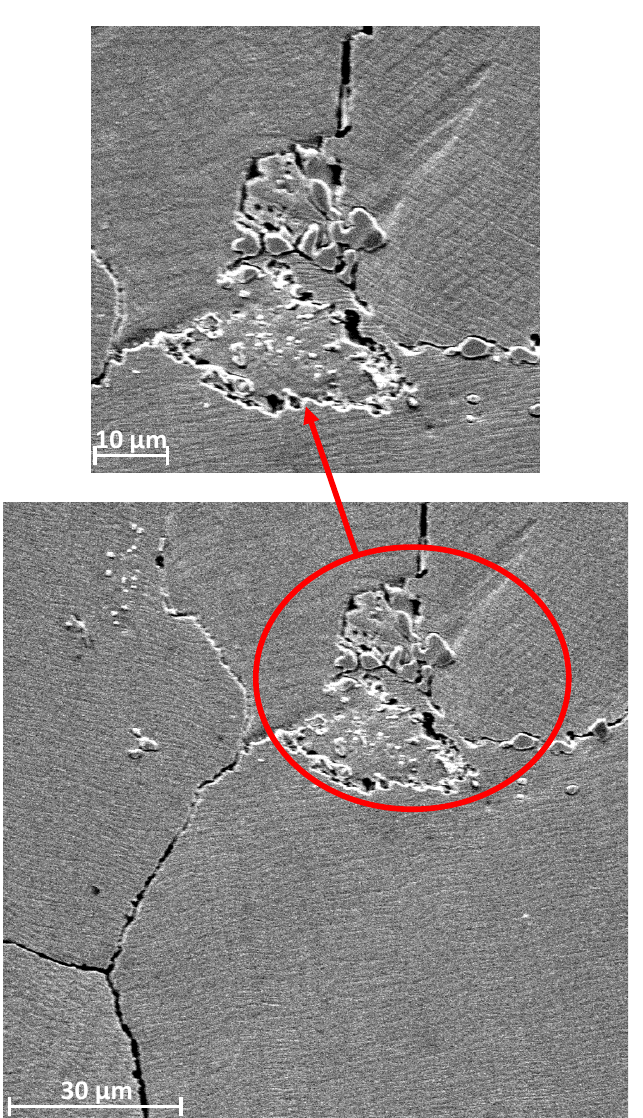
Figure 12. An exemplary view of the topography of the third zone surface with visible branched cracks and extended intergranular boundaries.